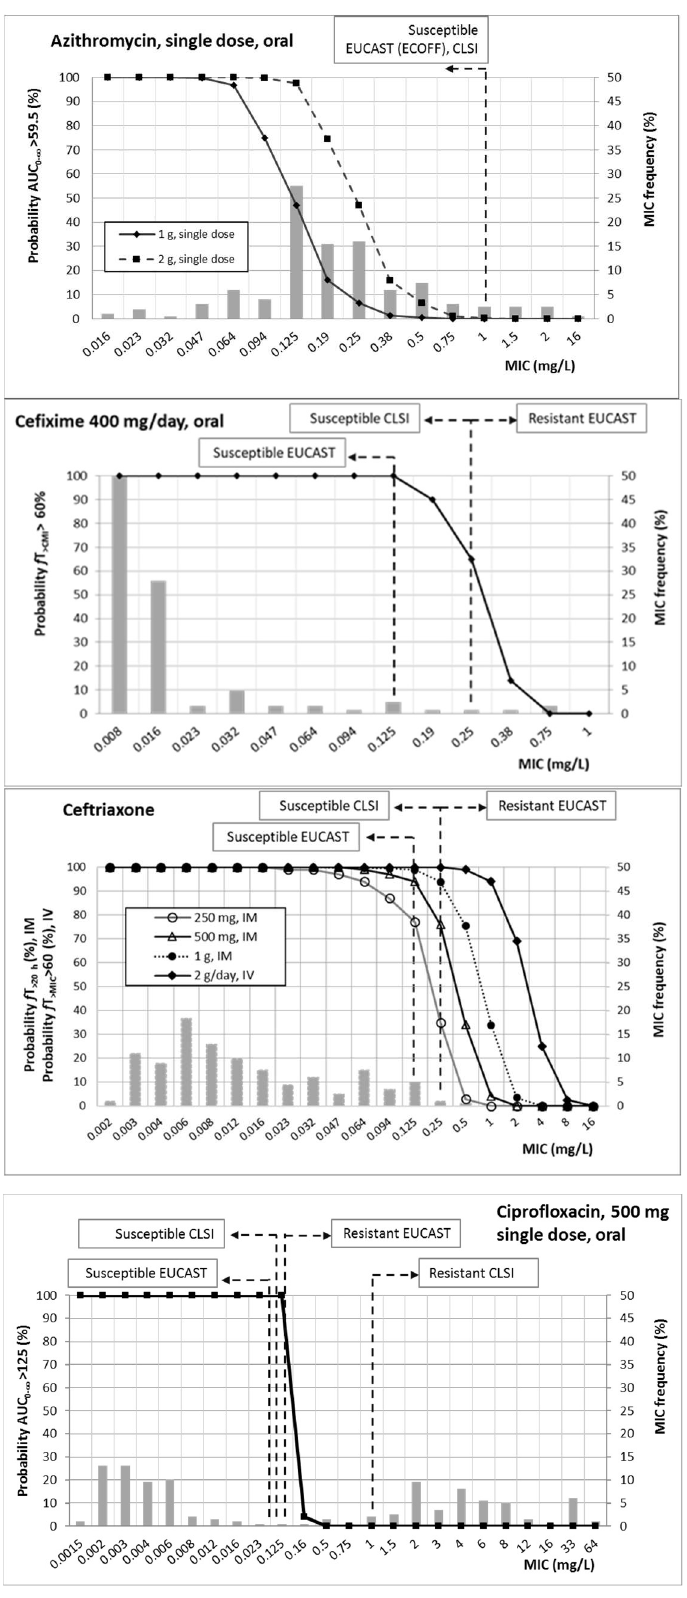
Figure 2. Probability of target attainment (PTA) of azithromycin, ceftriaxone, cefixime, and ciprofloxacin. Grey bars: MIC frequency. Table 4 features the CFR values obtained after the PK/PD analysis and Monte Carlo simulations. Values higher than 90% were only achieved with the two cephalosporins. Table 4. Cumulative fraction of response (CFR) calculated for all antibiotics and dosing regimens.